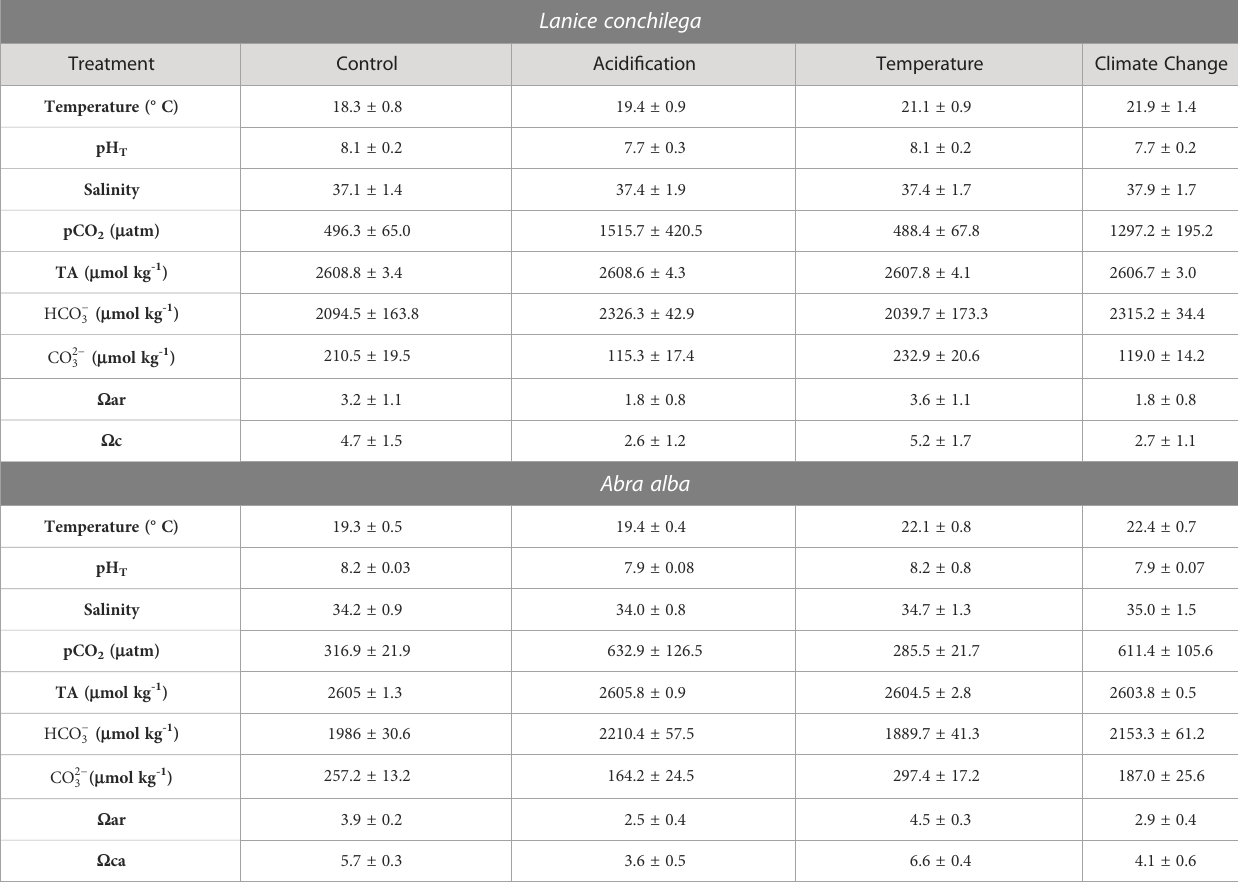
TABLE 1 Water chemistry over the duration of the experiments: temperature, total pH, salinity, partial pressure of carbon dioxide (pCO 2 ), total alkalinity (TA), bicarbonate concentration ( HCO 3 ), carbonate concentration ( CO 2 3 ), saturation state of aragonite ( W ar) and saturation state of calcite ( W